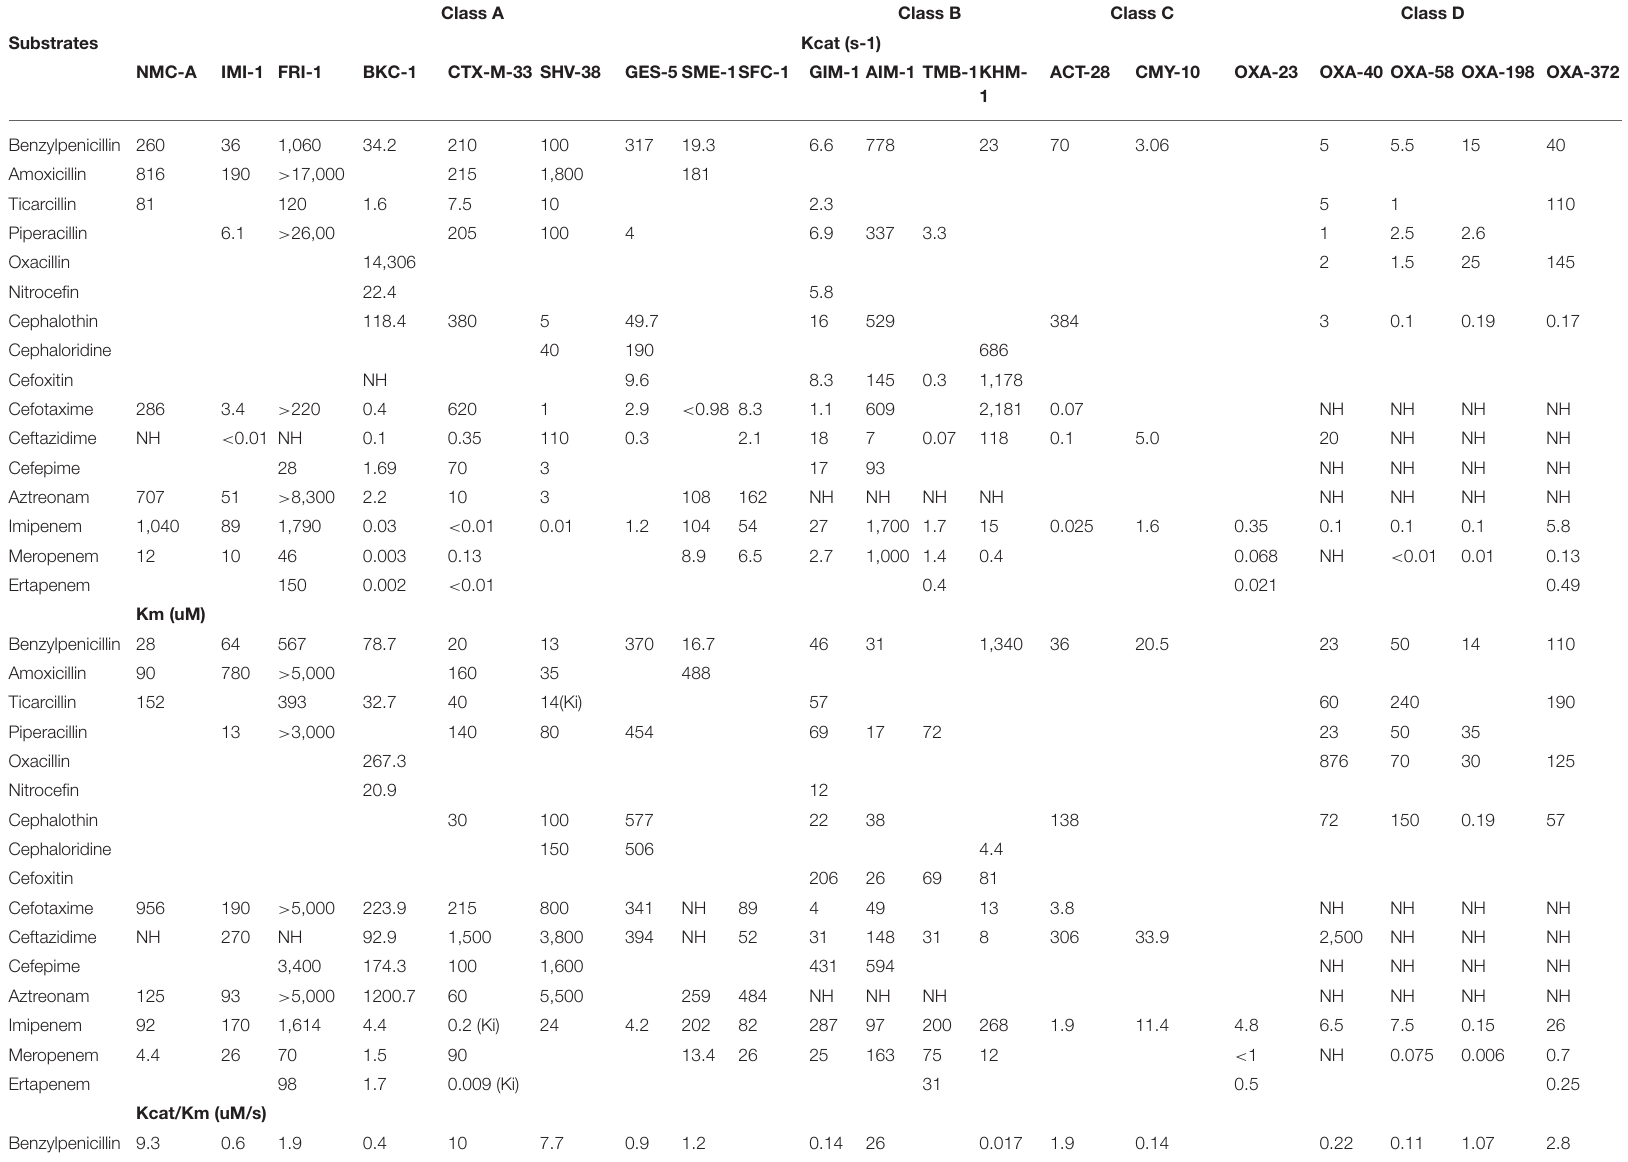
TABLE 2 | Kinetics of minor